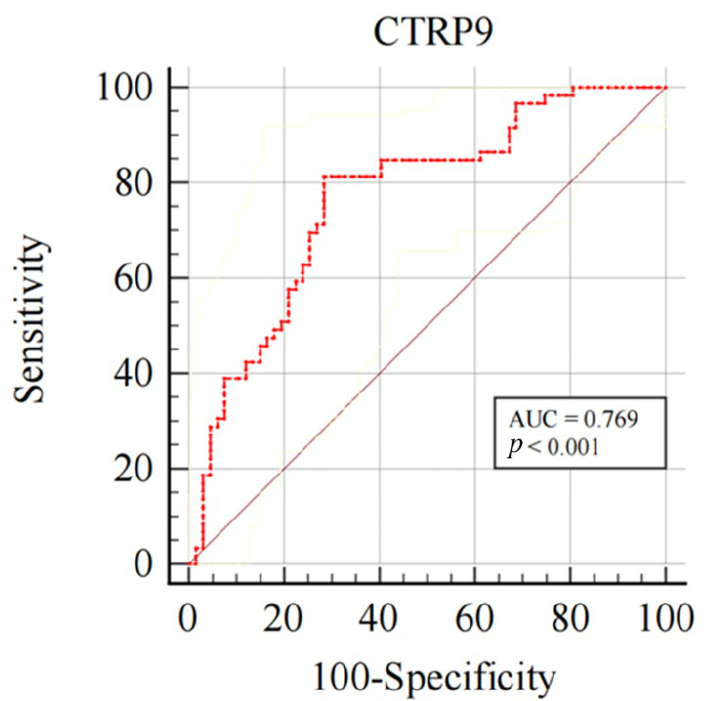
Figure 4. Predictive value of plasma CTRP9 level on calcification severity. Receiver operating characteristic (ROC) curves for predicting calcification severity. The AUC was 0.769 (95% CI: 0.685–0.839, p < 0.001), the cut-off value was 89.13 pg/mL (sensitivity 81.40%, specificity 71.60%). CI, confidence interval; CTRP9, C1q/TNF-related protein 9.